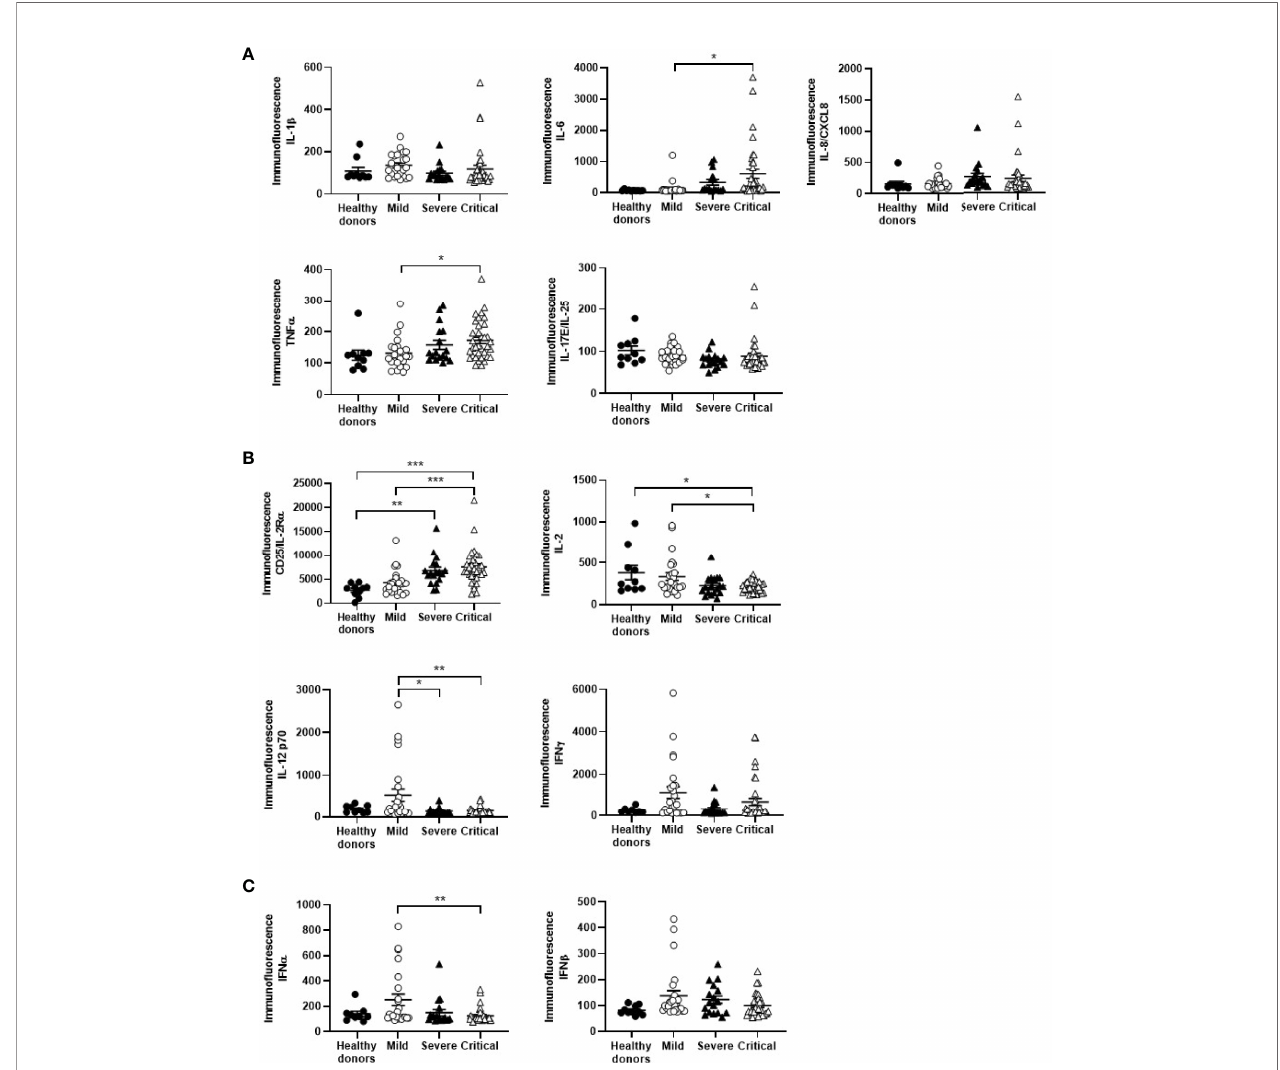
FIGURE 1 | Cytokine pro fi le in plasma of patients with different stages of COVID-19. The levels of chemokines and proin fl ammatory cytokines (A) , cytokines involved in Th1 differentiation and survival (B) , and cytokines with antiviral activity (C) were analyzed in plasma of patients with mild, severe and critical COVID-19, in comparison with healthy donors. Each dot corresponds to one sample and lines represent mean ± standard error of the mean (SEM). Statistical signi fi cance was calculated using one-way ANOVA and Tukey ’ s multiple comparisons test. * p < 0.05; ** p < 0.01; *** p <